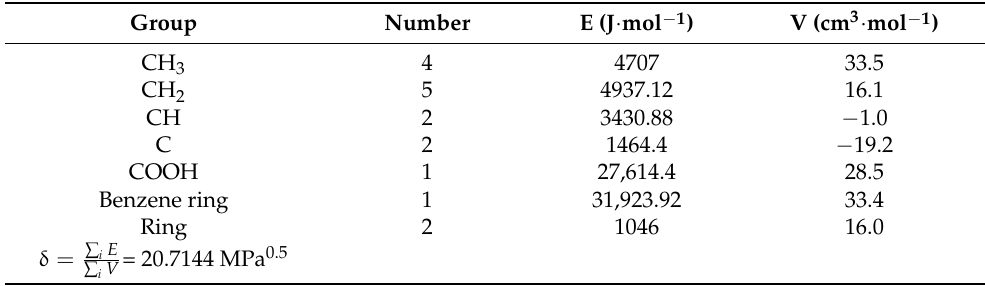
Table 15. The Hansen solubility parameter (HSP) for dehydroabietic acid was calculated using the group contribution method a